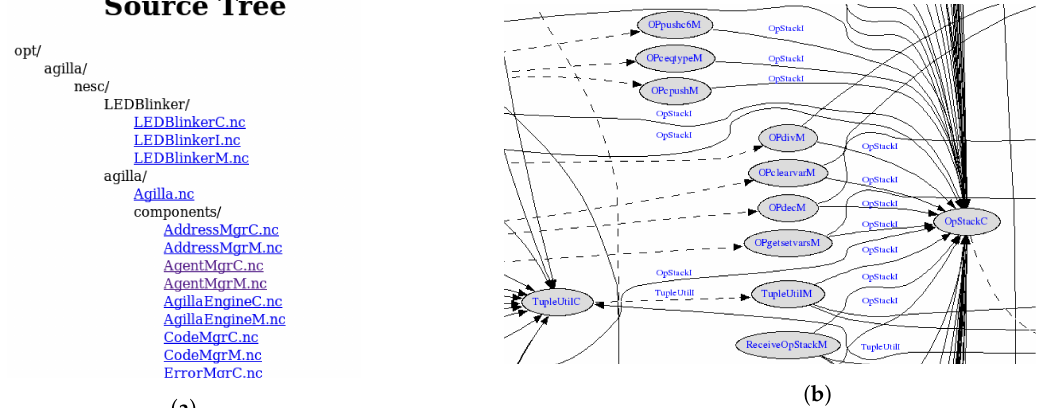
Figure 4. Agilla: components list and relations between them. ( a ) List of components and interfaces in Agilla. ( b ) Components graph from nesdoc